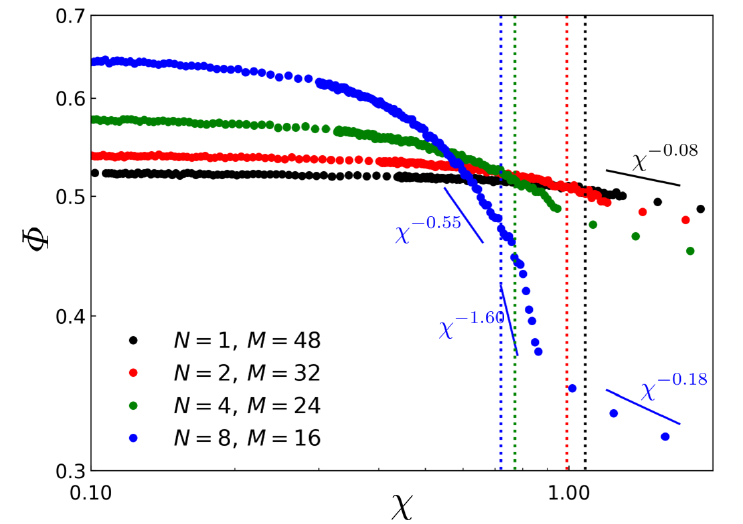
Figure 4. The fractions of bridge conformation, Φ , versus χ for the simulated L-TBC and C-TBC samples. The vertical dashed lines represent the χ ODT for the corresponding copolymer